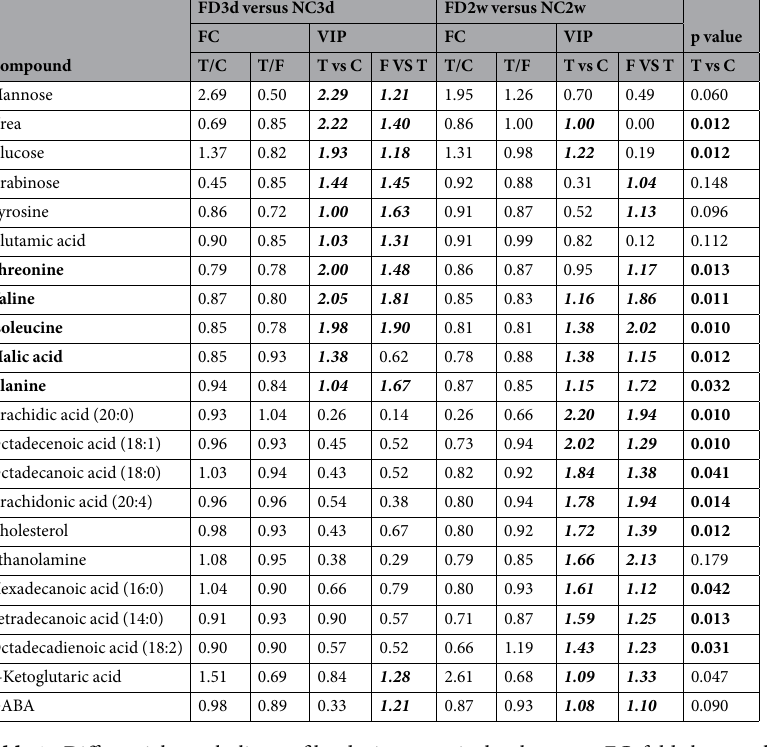
Table 1. Differential metabolite profiles during myopia development. FC: fold change, abundance of individual metabolites in the former versus the latter group. T: FD eyes; F: fellow eyes; C: normal control eyes. VIP: variable importance in the OPLS model discriminating two groups. P values are from two-way ANOVA assessing main effect of treatment type (with or without FD), adjusted by FDR method with q value set at 0.05. Compound changes with VIP > 1.0 and P < 0.05(shown in italic bold) were regarded as significant. The five listed boldface compounds were significantly different in both FD3d versus NC3d and FD2w versus NC2w. Except for them, the first 6 compounds in the table were significantly different in FD3d versus NC3d and the bottom 11were significantly different in FD2w versus